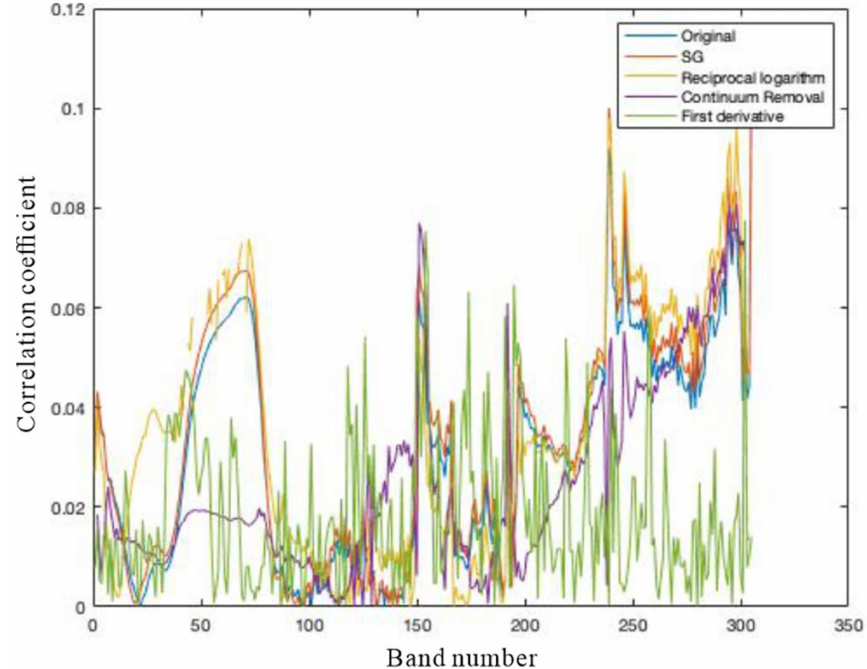
Figure 10. Correlation analysis results between spectra and Au measured content for prepro- cessed